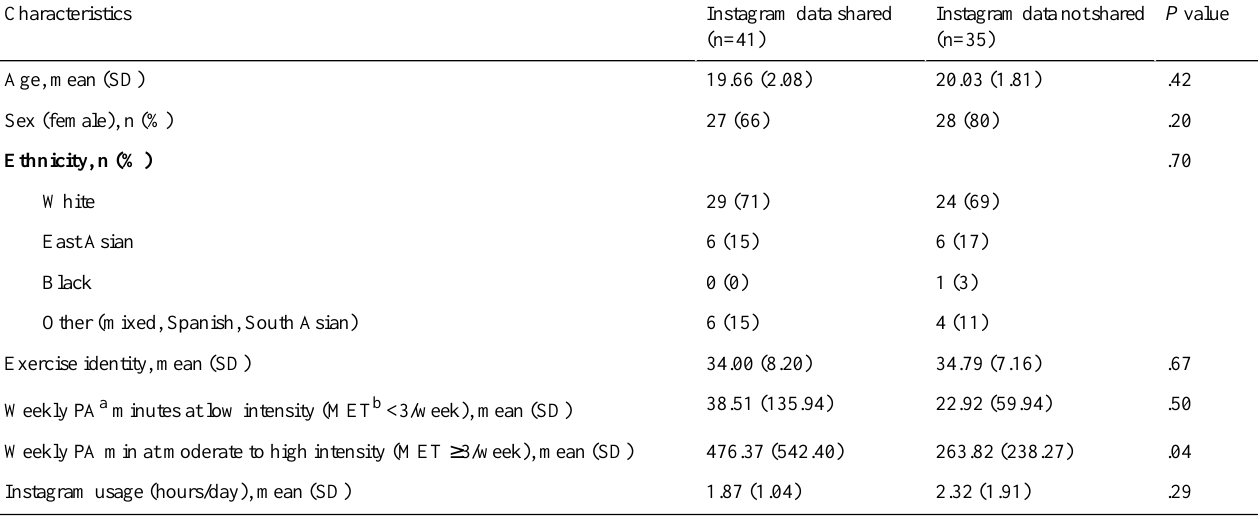
Table 1. Baseline characteristics.